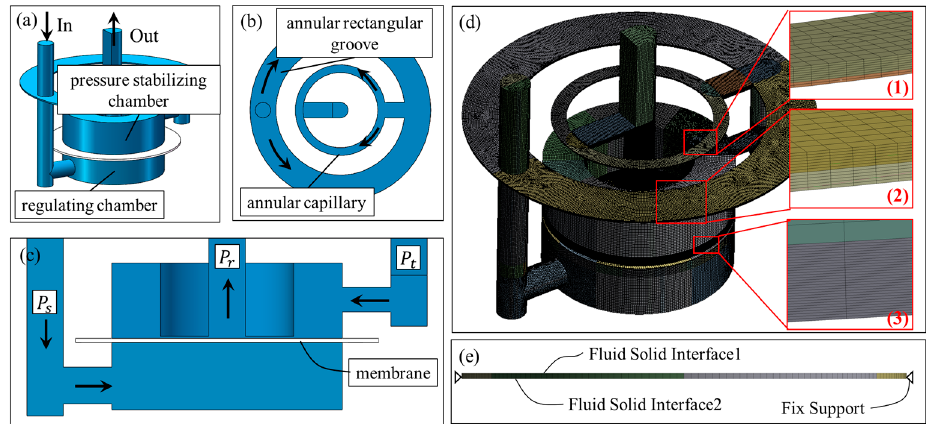
Figure 9. Geometric model and mesh model of PSMR. ( a – c ) the geometric model; ( d ) the mesh model of the fluid domain; ( e ) the mesh model of the membrane.